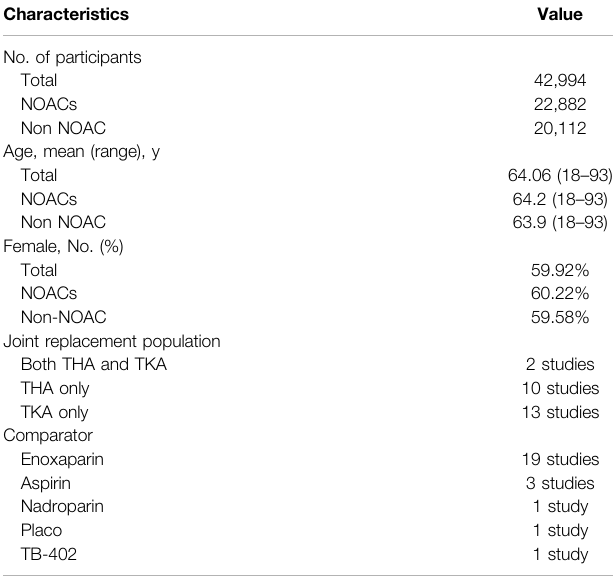
TABLE 1 | Characteristics of the included 25 randomized clinical trials Characteristics